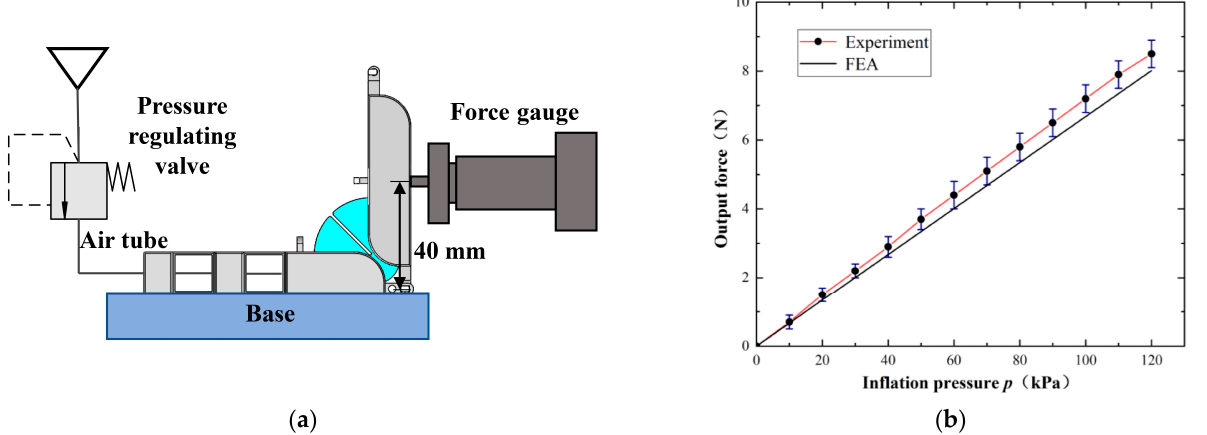
Figure 9. Test of output force. ( a ) Experimental platform of output force; ( b ) Comparison results.